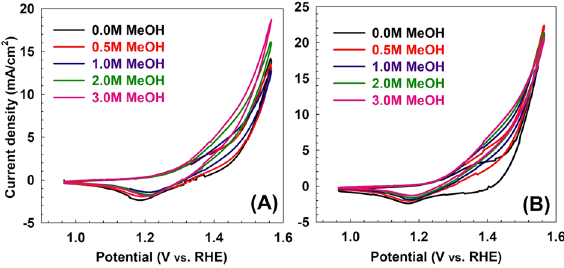
Figure 7. Cyclic voltammetry of samples calcined at 200 °C ( A ) before and ( B ) after MO adsorption for different methanol oxidation at 50 mV/s scan rate.